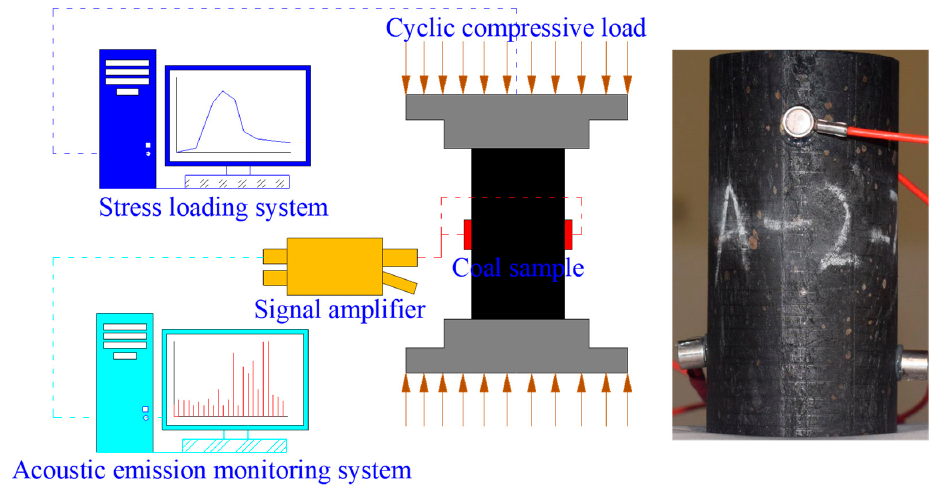
Figure 5. Illustration of the rock dynamics and acoustic emission testing system.